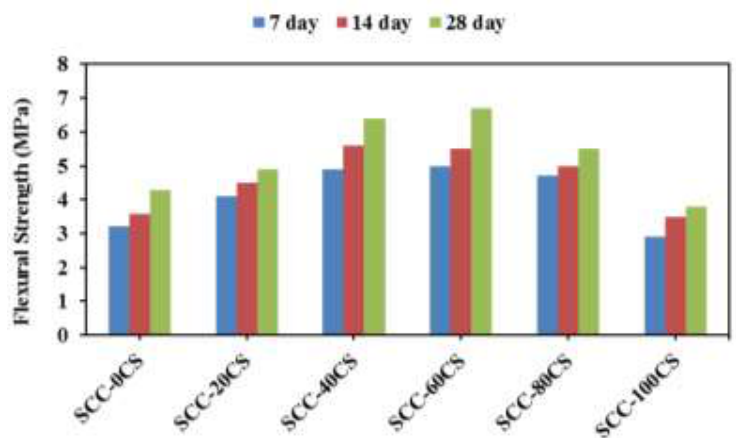
Figure 8. Variation of 7, 14 and 28 day flexural strength for various percentages of copper slag replacement